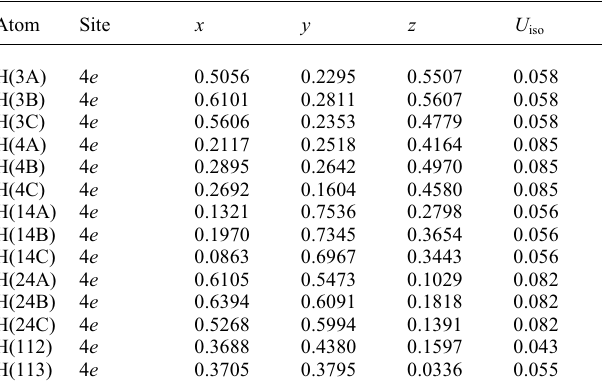
Table 2. Atomic coordinates and displacement parameters (in Å 2 ) .